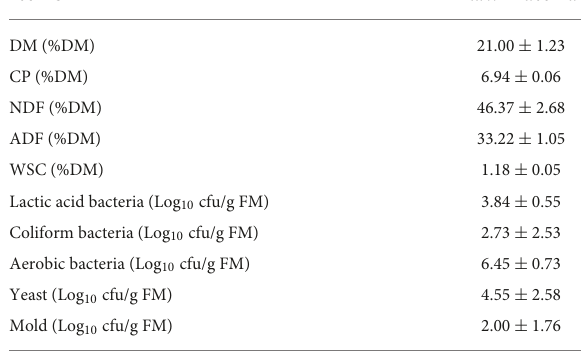
TABLE 1 Chemical and microbial composition of pre-ensiled amaranth.